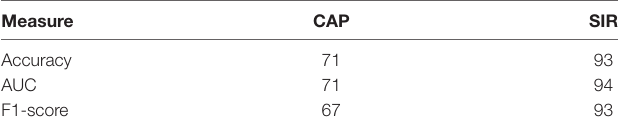
TABLE 2 | Maximum performance (%) of SVM classifier for distinguishing hearing and speech rehabilitation effects (good and poor). Measure CAP SIR Accuracy 71 93 AUC 71 94 F1-score 67 93 F1-score = 2 (precision × recall)/(precision +